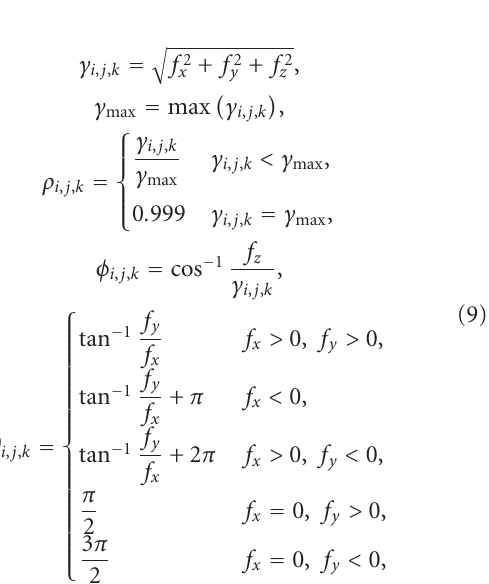
Figure 2: A slice of 3D GCM of MRI T1. (a) Original image, (b) gradient magnitude map, (c) gradient phase map, (d) GCM ( Δ ρ = 1 / 16, Δ θ = π/ 8, Δ φ = π/ 8, and Th = 0 . 10).